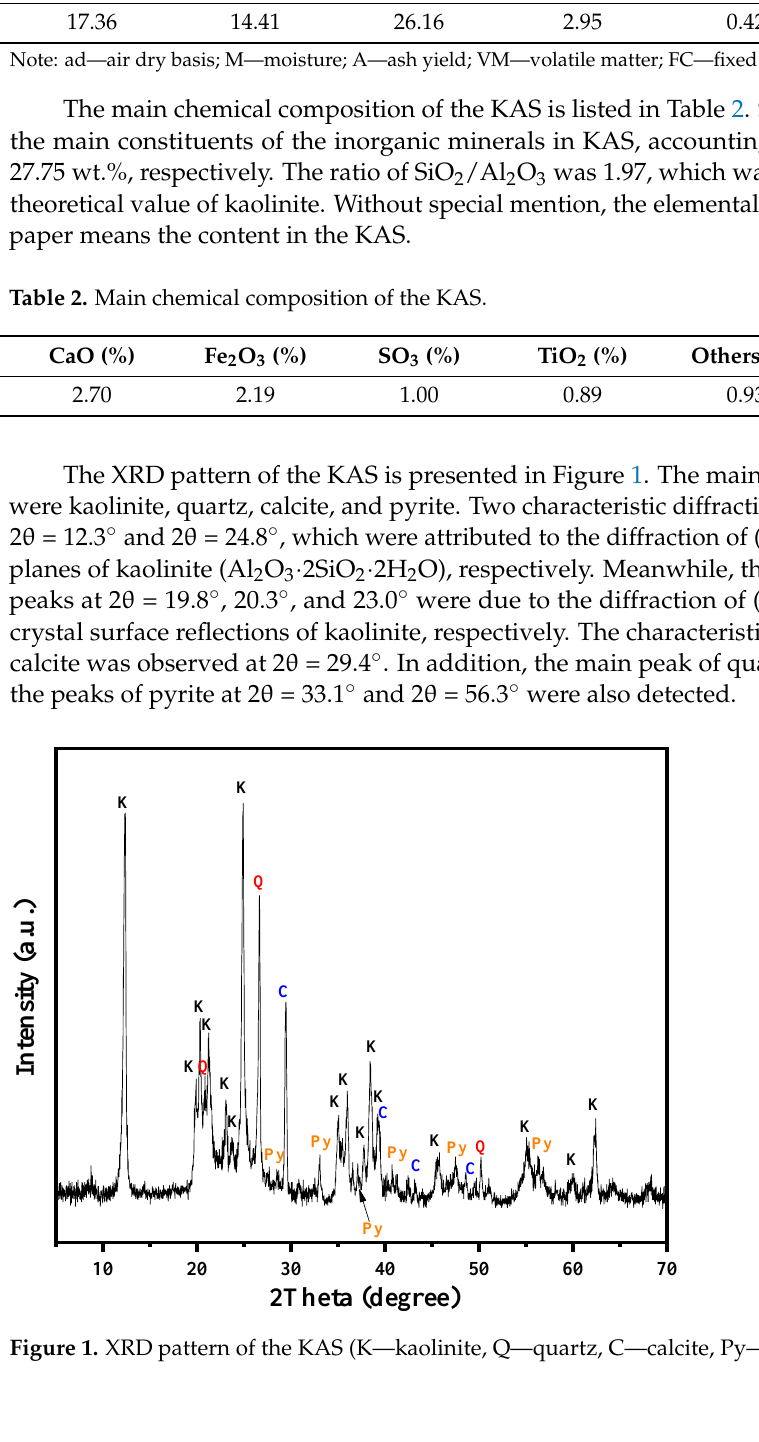
Table 1. Proximate and ultimate analyses of the kaolinite-based high ash slime (KAS). Proximate Analysis, ad (wt.%) Ultimate Analysis, ad (wt.%)